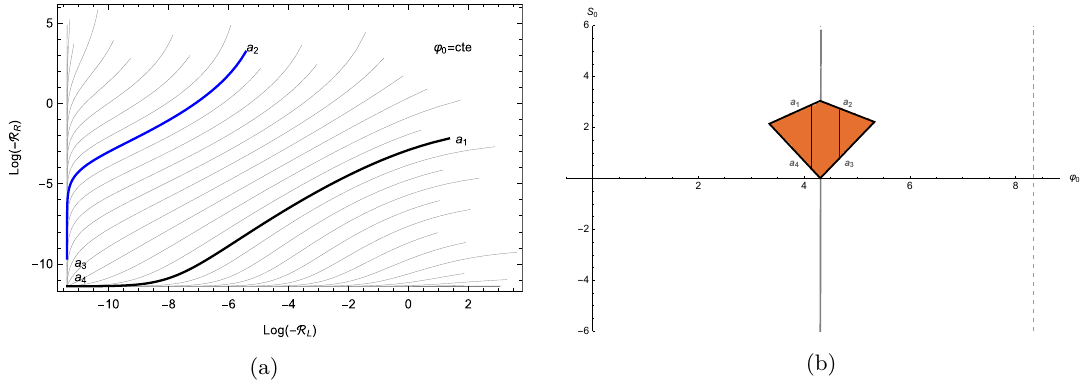
Figure 12 . The relation between left and right dimensionless curvatures at fixed ϕ 0 (while varying S 0 ). For example, the points on the blue curve in figure (a) are in a one-to-one relation with the points on the blue vertical line in figure (b) at ϕ